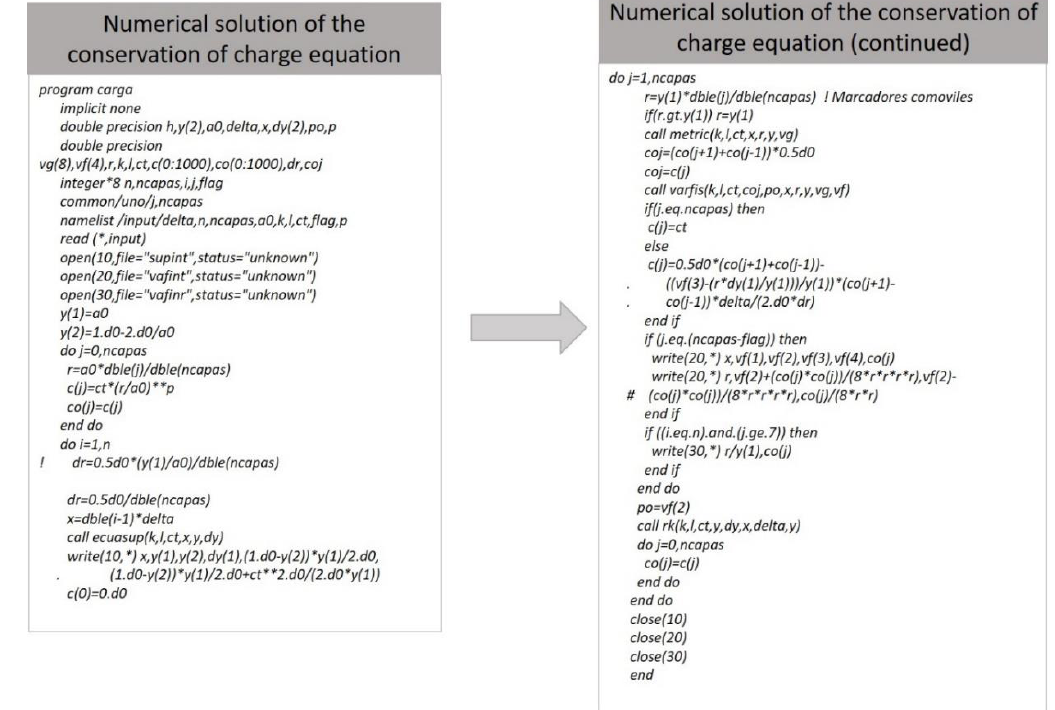
Figure 2. Numerical solution of the conservation of charge equation. Figure 3 models the rate of change of the radius of the distribution over time, where it is observed that it collapses inexorably. In addition, the evolution of the physical varia- bles is shown.